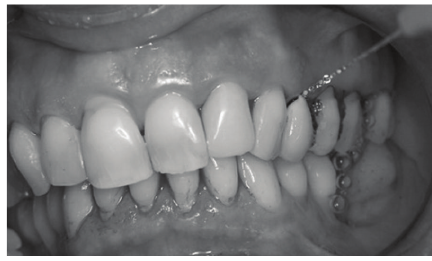
Figure 3: Rinsing the fluid off the pocket.